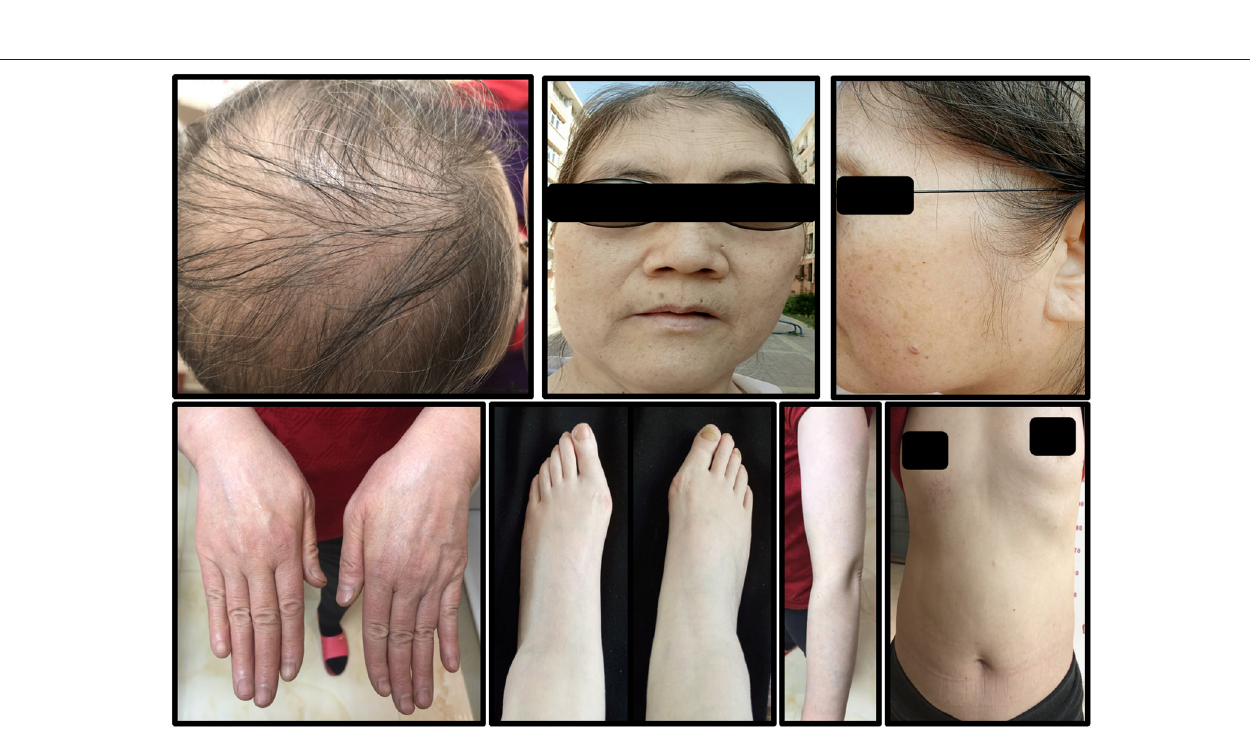
FIGURE 4 | The symptoms of the patient after 2 years of treatment. A small amount of hair had grown and all skin lesions had disappeared.